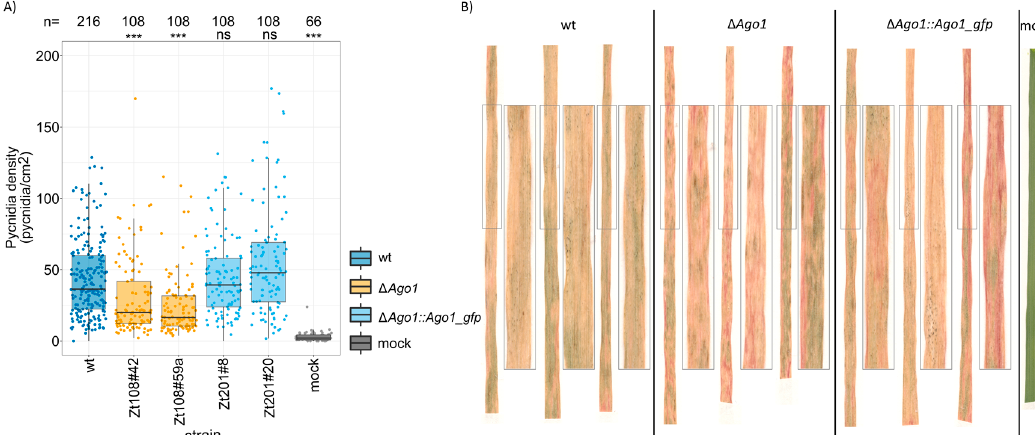
Figure 2. AGO1 affected the ability of the fungus to infect and propagate in planta . Two independent Ago1 -deletion strains ( ∆ Ago1 , orange) showed significantly lower density of pycnidia on the leaf surface at 21 dpi (days post inoculation) than the IPO323 wildtype (wt, dark blue). Complementation of the deletion by the wt Ago1 allele in its genomic locus (light blue) restored the wt phenotype. Statistical significance was inferred by ANOVA on ranked Pycnidia densities using the model pycnidia density~strain * experiments * operator with a post hoc Tukey’s HSD in a pairwise comparison to the IPO323 wt. Pooled data from three independent experiments are shown. ( B ) Example pictures of infected wheat leaves with wt (IPO323), ∆ Ago1 deletion and ∆ Ago1::Ago1_gfp complementation clones. Enlarged are representative portions of the leaf. Although all Z. tritici strains induced full necrosis of infected leaf portions the ∆ Ago1 deletion clones showed a reduced ability to produce pycnidia. ( A ) Categorized p -values of Tukey’s HSD post-hoc test on an ANOVA on ranked pycnidia density are shown (ns: not significant, ***: p < 0.0005).